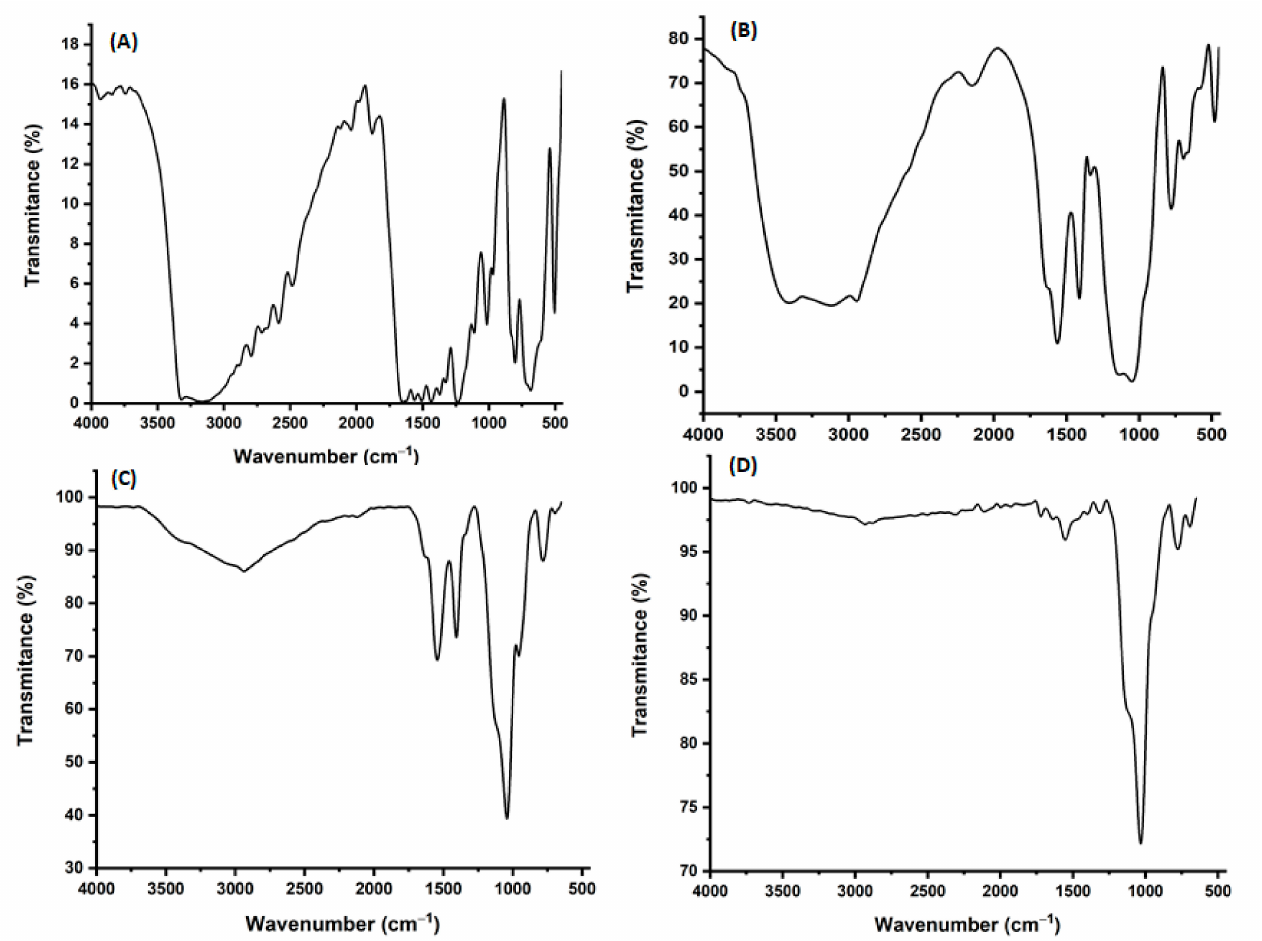
Figure 1. FTIR spectra for ( A ) ACT, ( B ) ACT-MIP (before template removal), ( C ) ACT-MIP, and ( D )